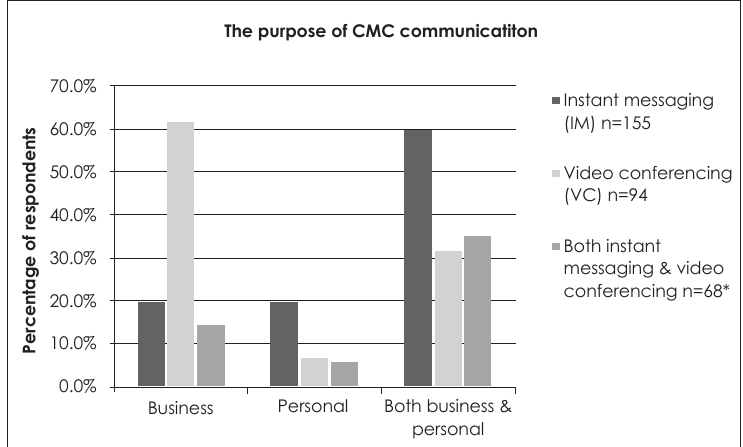
Figure 1: Purpose of CMC tool